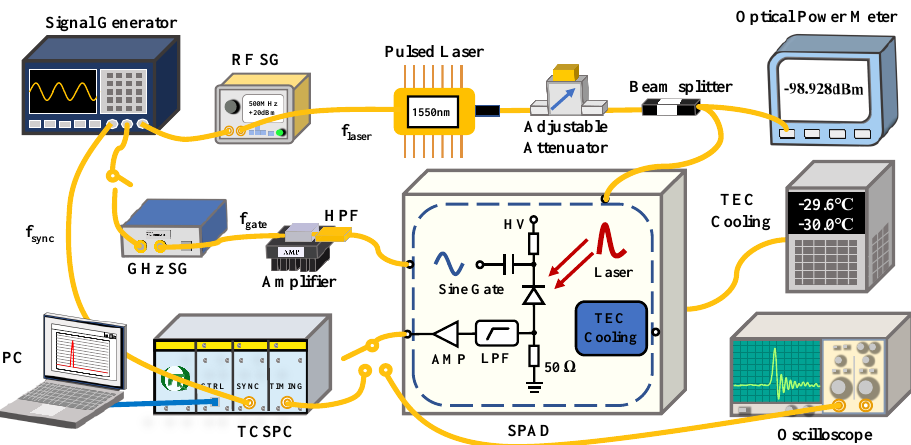
Figure 1. Schematic setup of the 1-GHz sinusoidally gated free-running InGaAs/InP APD. SG: signal generator; HPF: high-pass filter; LPF: low-pass filter; AMP: amplifier; TCSPC: time-correlated single-photon counter; SPAD: single-photon avalanche photodiode.